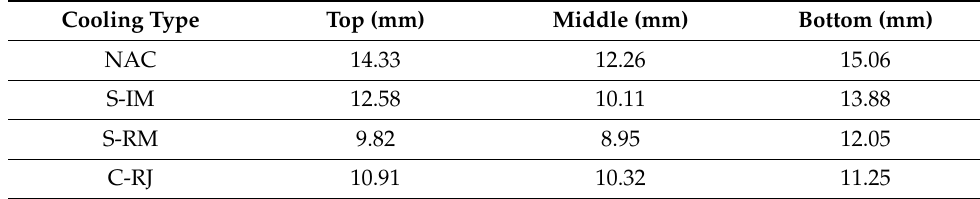
Table 2. Dimensions of width of WNZ.